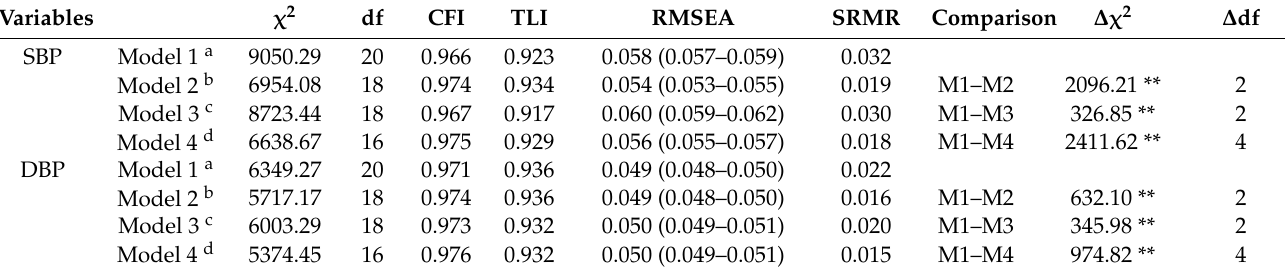
Table 3. Model fit and model